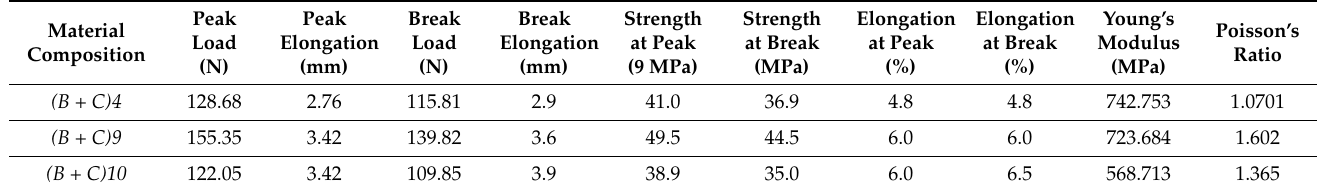
Table 11. Tensile testing of B and C and ABS at different